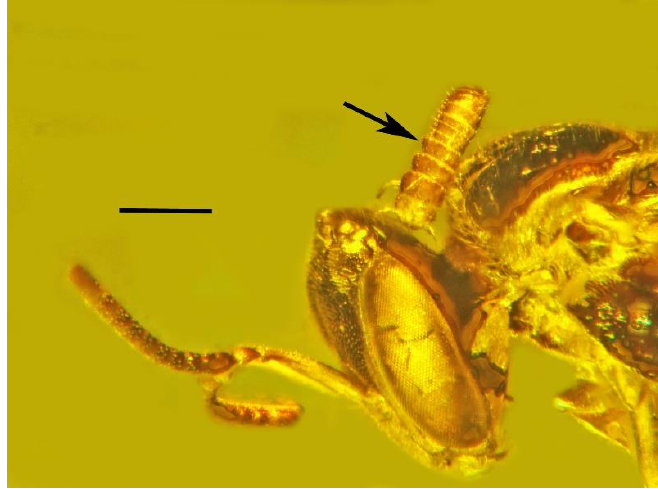
Figure 20. Meloid triungulin (Coleoptera: Meloidae) (arrow) on a stingless bee (Hymenoptera: Apidae) in Dominican amber. Scale bar = 400 µm.